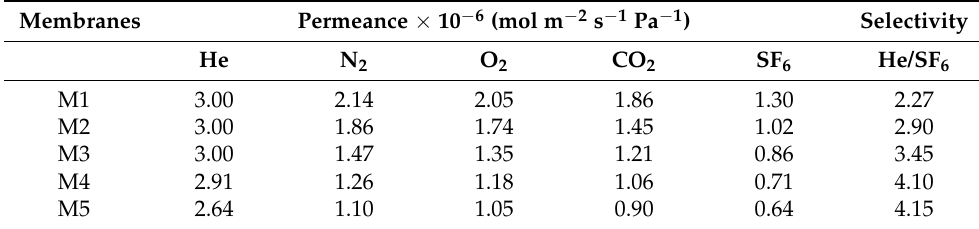
Table 3. Single gas permeance data of synthesized CHA zeolite membranes.